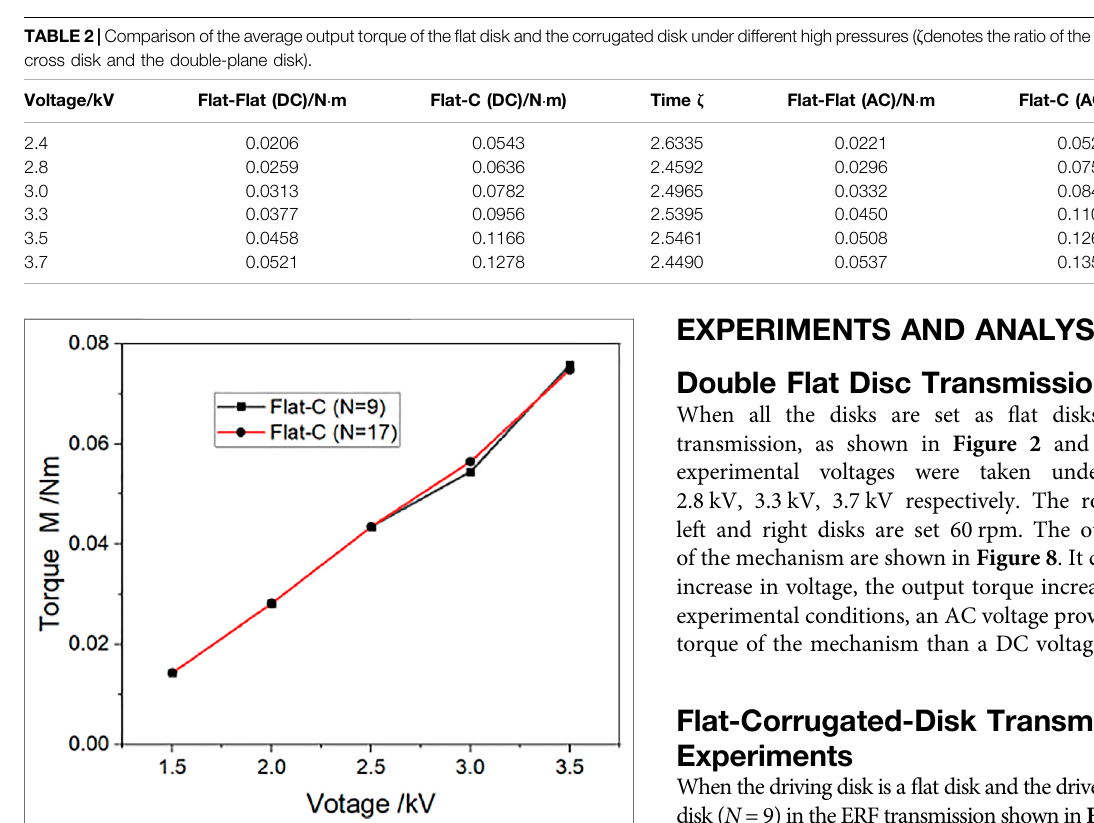
FIGURE 10 | In fl uence of the corrugated disk heads number N on the torque.